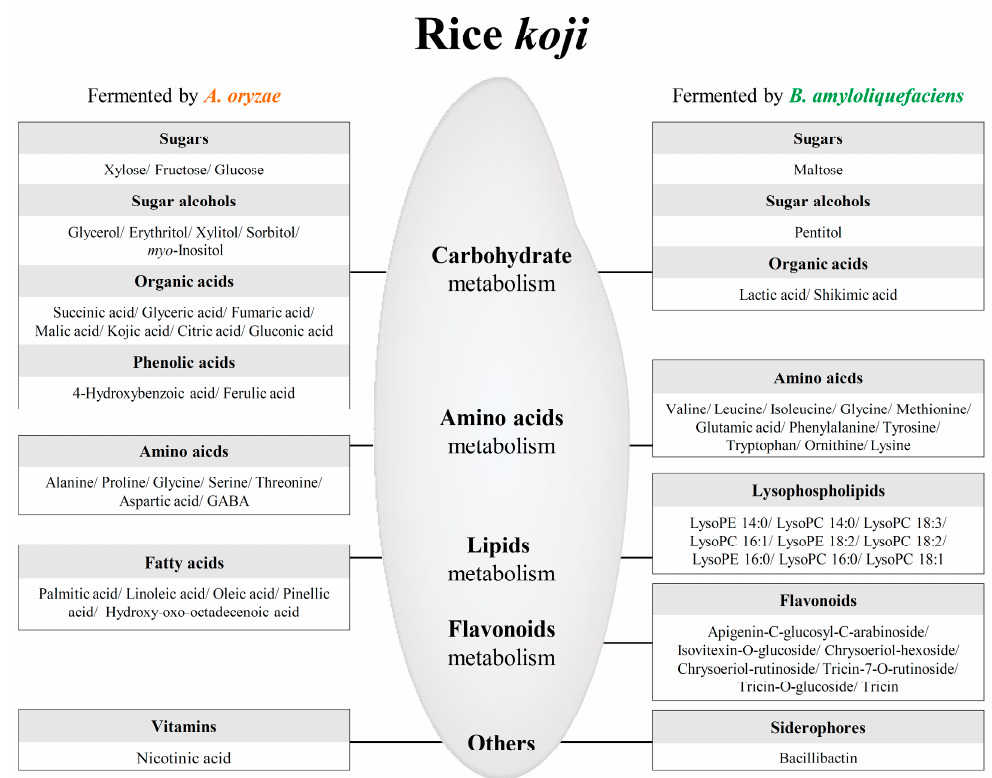
Figure 5. The metabolic comparison between rice koji fermented with A. oryzae for 24 h (RK_ AO 24 h) or B. amyloliquefaciens for 24 h (RK_ BA 24 h). The selected metabolites are variables of OPLS-DA in Figure 2. The metabolite located on left has higher relative content in RK_ AO 24 h, while that of located on right was higher in RK_ BA 24